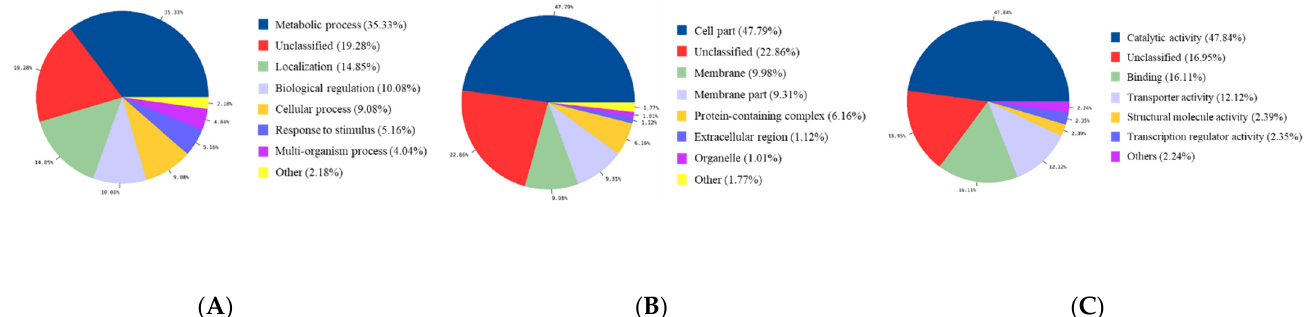
Figure 5. Significantly enriched gene ontology terms of differentially expressed genes. ( A ) Biological process; ( B ) cellular component; ( C ) molecular function.